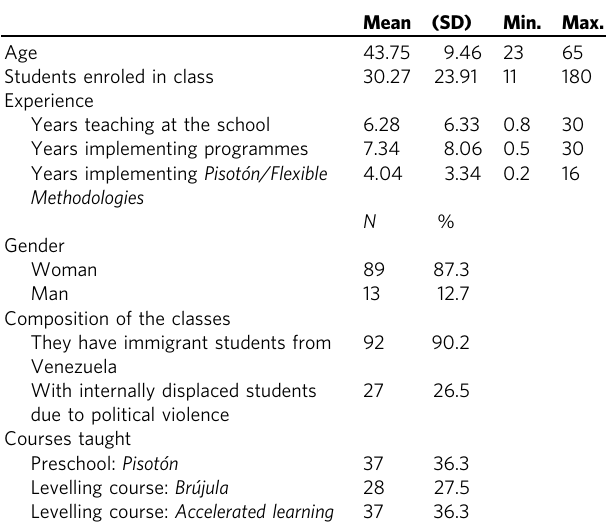
Table 1 Characteristics of the participants in the study ( n =